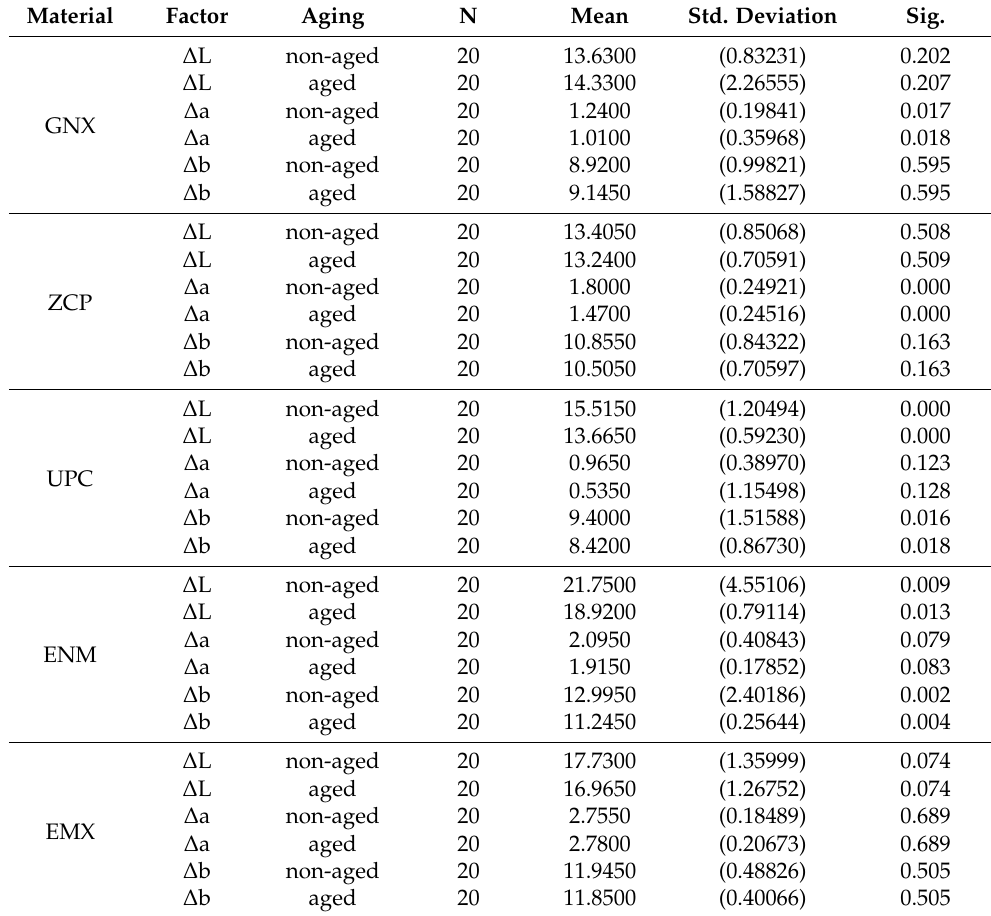
Table 3. Descriptive CIE ∆ L ∆ a ∆ b values on white and black background with and without aging. Shaded cells indicate significant differences p <